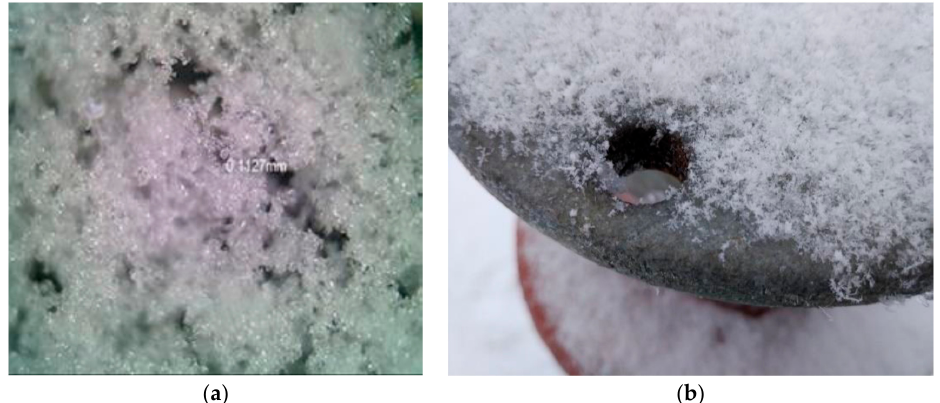
Figure 3. Appearance of a snowflake under different environmental conditions. ( a ) Snowflake of artificial snow; ( b ) snowflake of natural snowfall.